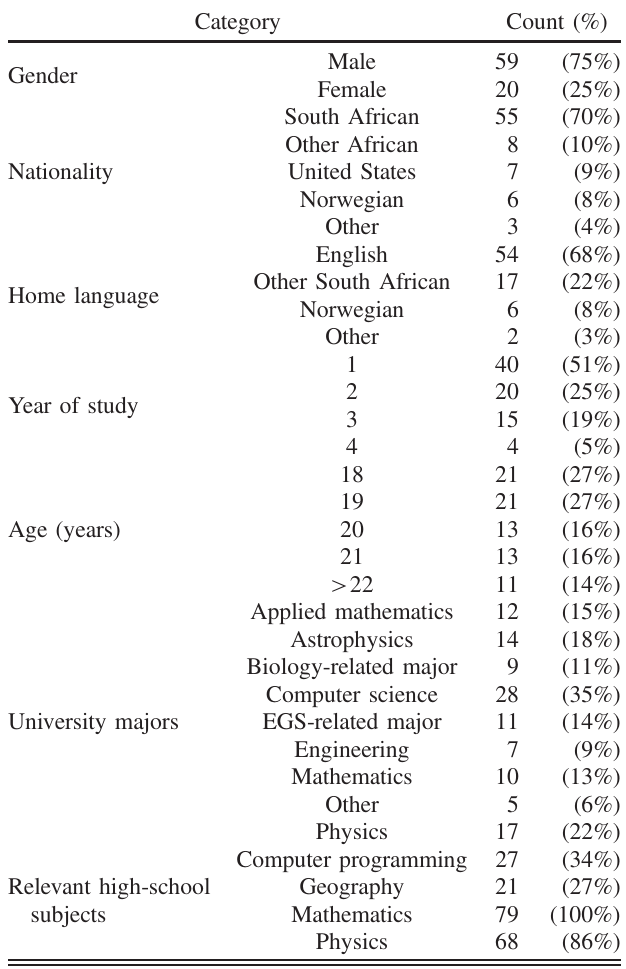
TABLE I. Summary of demographic information obtained from a sample of 79 students taking the AST1000F course in 2013. Here, EGS stands for Environmental and Geographic Sciences, and includes such fields as climatology, oceanography, and geology. The numbers presented for (selected) subjects taken in high school refer only to subjects taken by students in their final year of high